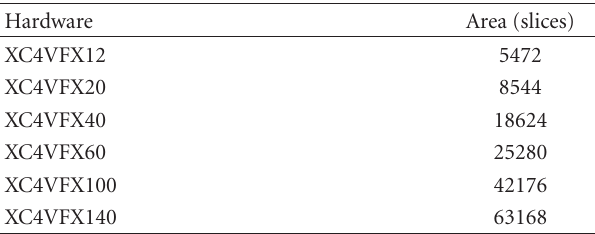
Table 1: Available area (in slices) for di ff erent FPGAs from